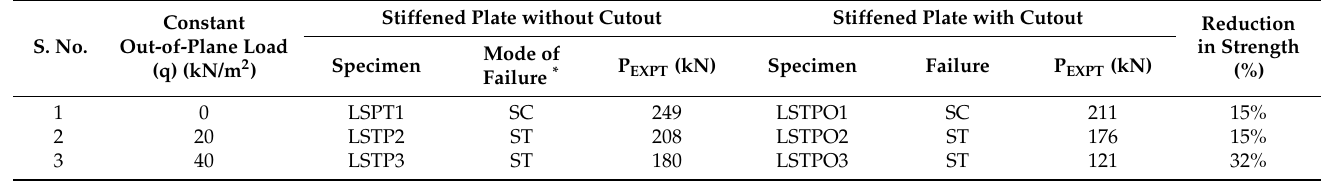
Table 7. Influence of square cutout on the ultimate axial load.